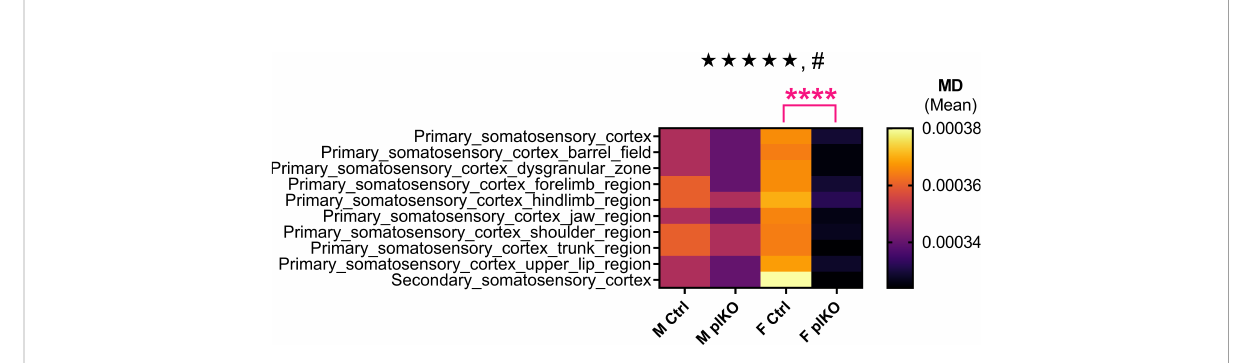
FIGURE 2 Diffusion Tensor Imaging (DTI) analysis in the somatosensory cortex of Ctrl and plKO mice at P30. Heatmap representing mean diffusivity (MD) across the different somatosensory areas. MD was signi fi cantly decreased in the female plKO somatosensory cortex, as compared with their littermate controls. Data presented in a hierarchical tree. Three-way sex by genotype by region ANOVA: main genotype effect: ★★★★★ p<0.0005; sex × genotype interaction: #p<0.05. Tukey ’ s multiple comparison test: ****p<0.001. n = 11 M Ctrl, 8 F Ctrl, 13 M plKO, 11 F plKO. F, female; M,